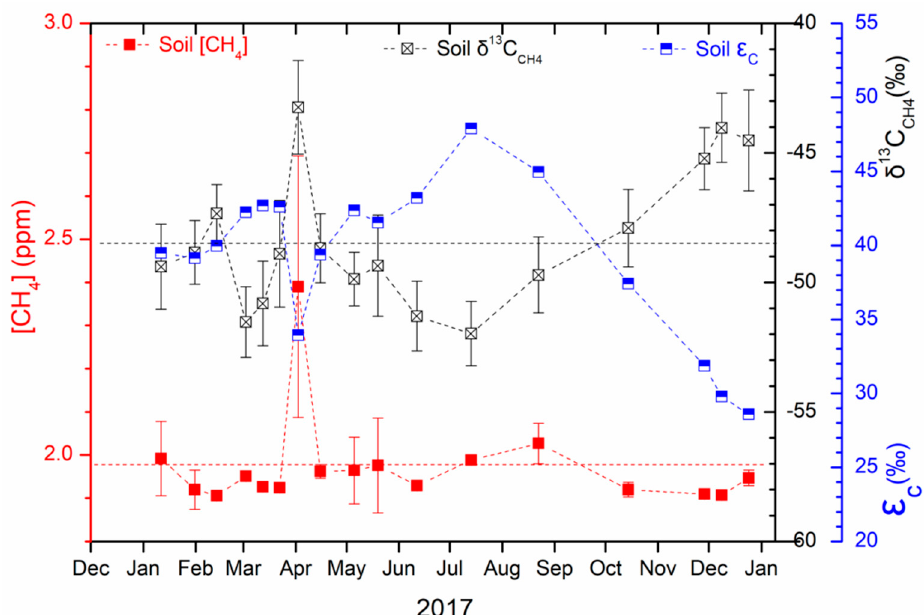
Figure 5. Content and stable carbon isotopic composition of methane ( δ 13 C CH4 ) and carbon isotope fractionation ( ε C ) between CO 2 and CH 4 in the free gas of the soil active layer.